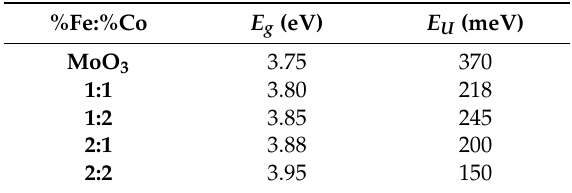
Figure 6. Transmission (T%) and reflection (R%) spectra of MoO 3 : Fe-Co thin films. Table 5. Optical band gap energy, E g , and Urbach energy, E U , for different content of iron and cobalt in the spray